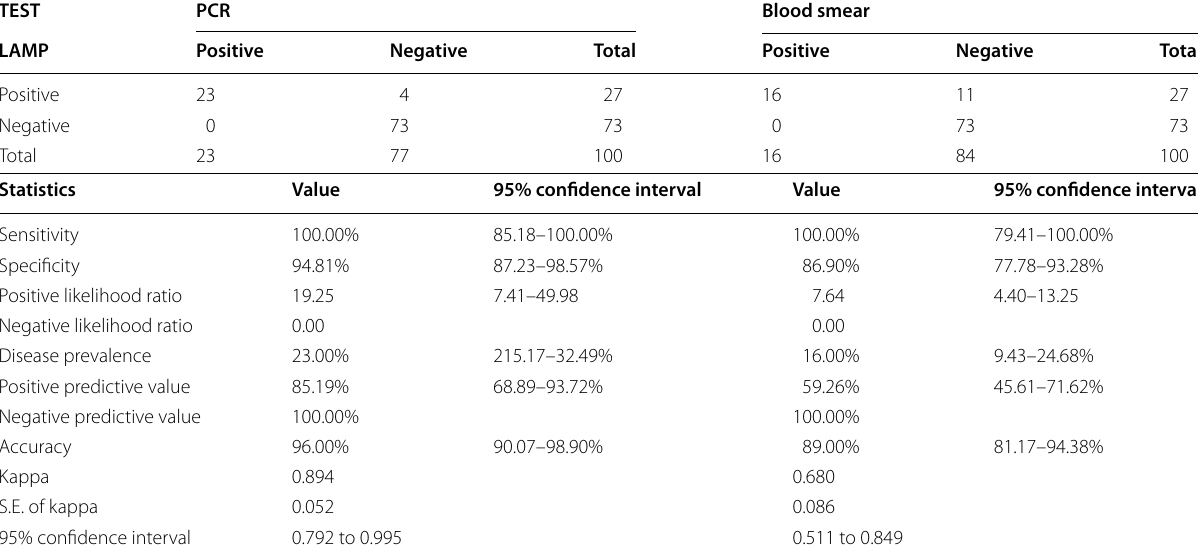
Table 1 Statistical analysis of results of comparison of LAMP with PCR and blood smear examination using MedCalc’s Diagnostic test evaluation